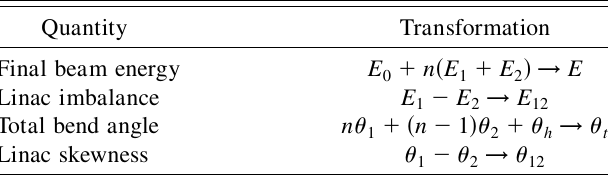
TABLE VI. Transformations to practical accelerator